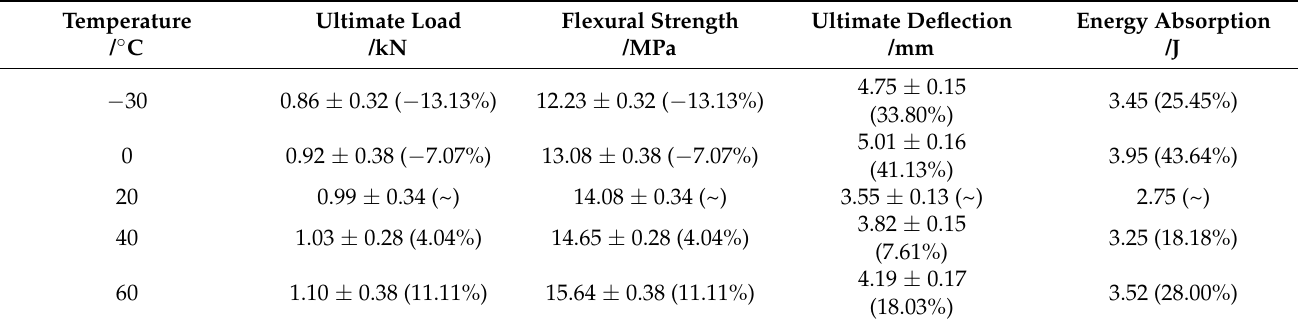
Figure 17. Relationship between feature parameters of fl exural property and temperature for HDC. ( a ) Flexural strength and de fl ection. ( b ) Energy absorption.